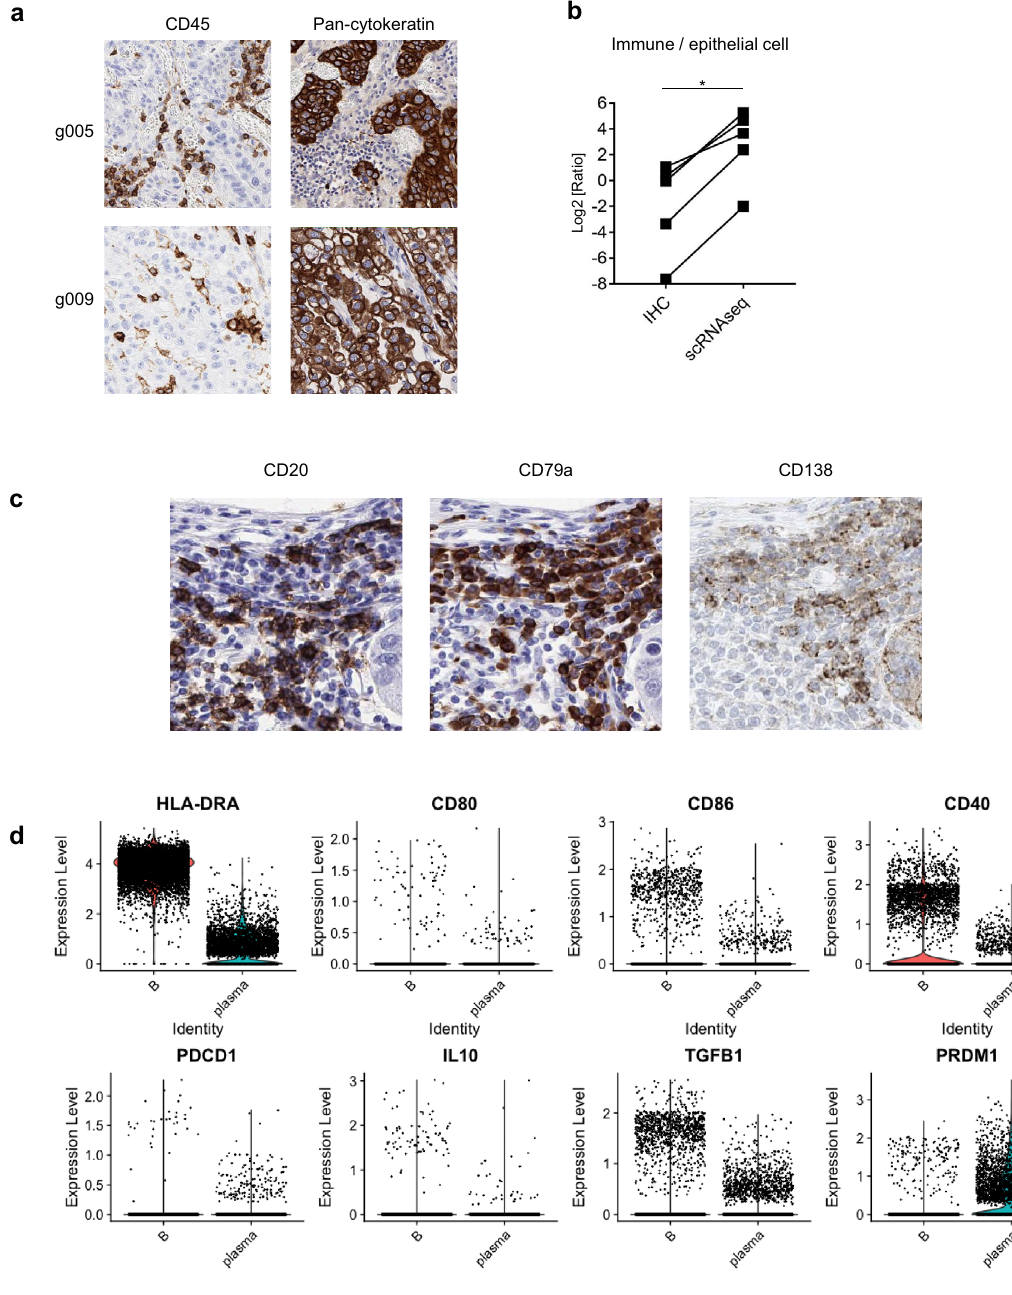
Figure 4. Comparison between scRNA-seq data using a droplet-based system and CyTOF data showed a little worse concordances in the TME. ( a ) Representative Immunohistochemistry (IHC) analysis for CD45 (left) and pan-cytokeratin (right). ( b ) Comparison between IHC and scRNA-seq with the ratio of epithelial cells / immune cells. Sample processing was performed as described in Fig. 3a. *p < 0.05. ( c ) Representative IHC analysis for plasma cells (CD138 + CD79a + CD20− cells). ( d ) Violin plots for comparison between tumor-infiltrating B cells and plasma cells based on scRNA-seq data. Antigen-presenting related genes (top) and regulatory B-cell related genes (bottom) are